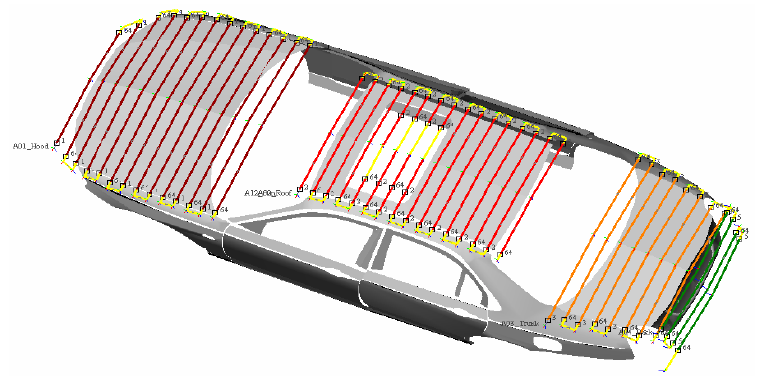
Figure 13. Automobile spraying line.